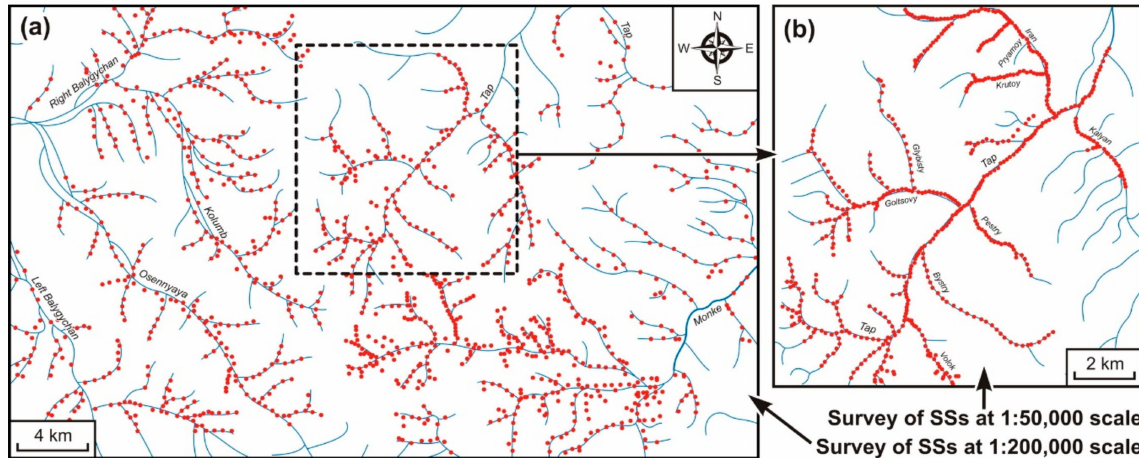
Figure 2. The alluvium samples’ locations (red points) in the survey of stream sediments (SSs) at 1:200,000 ( a ) and 1:50,000 ( b )